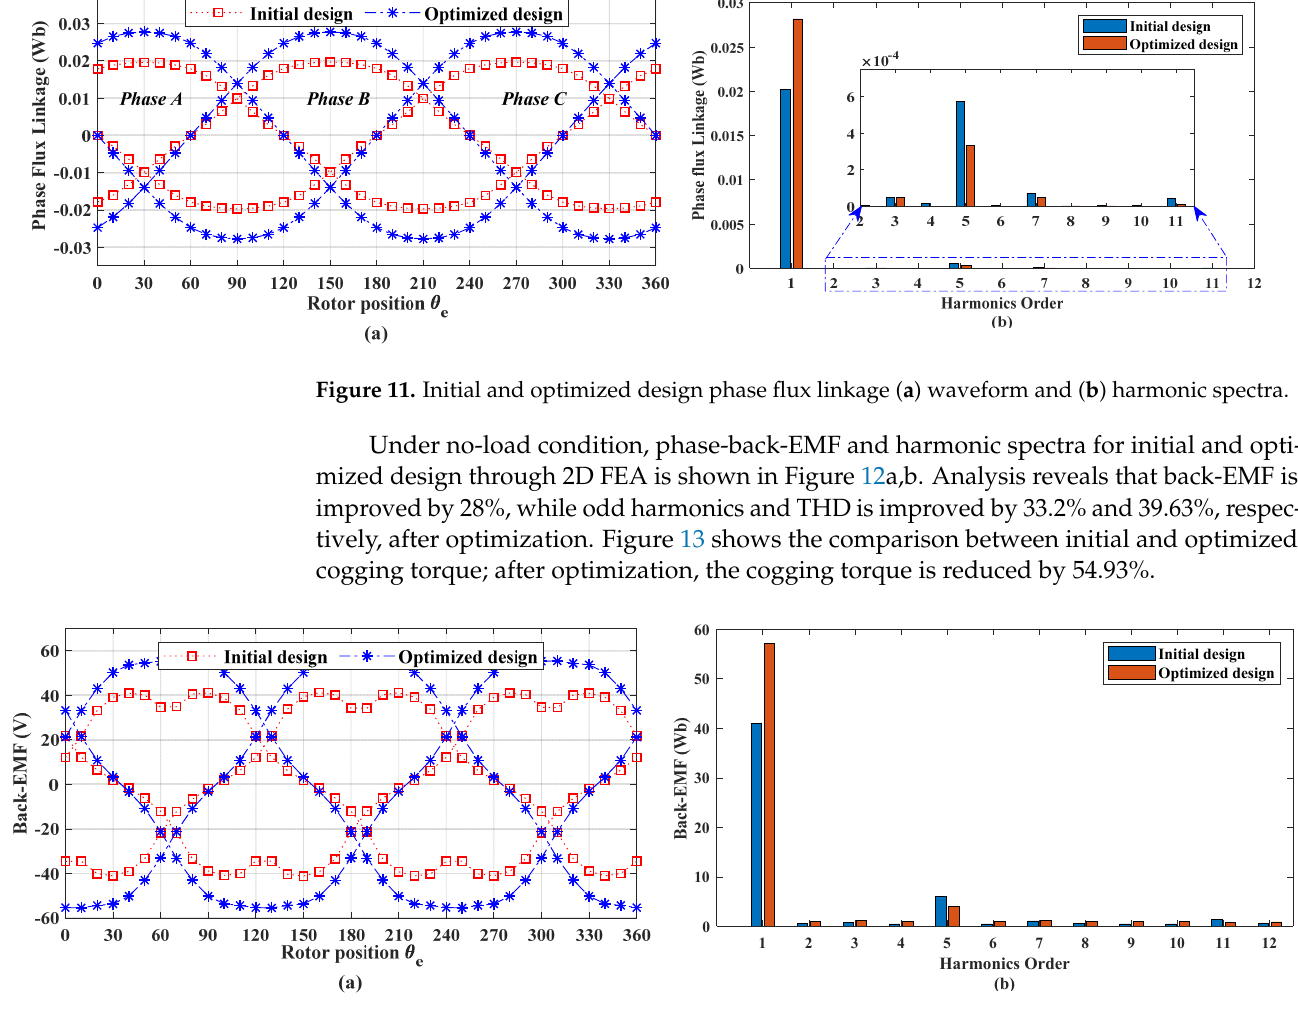
Figure 12. Initial and optimized design back-EMF ( a ) waveform and ( b ) harmonic spectra.